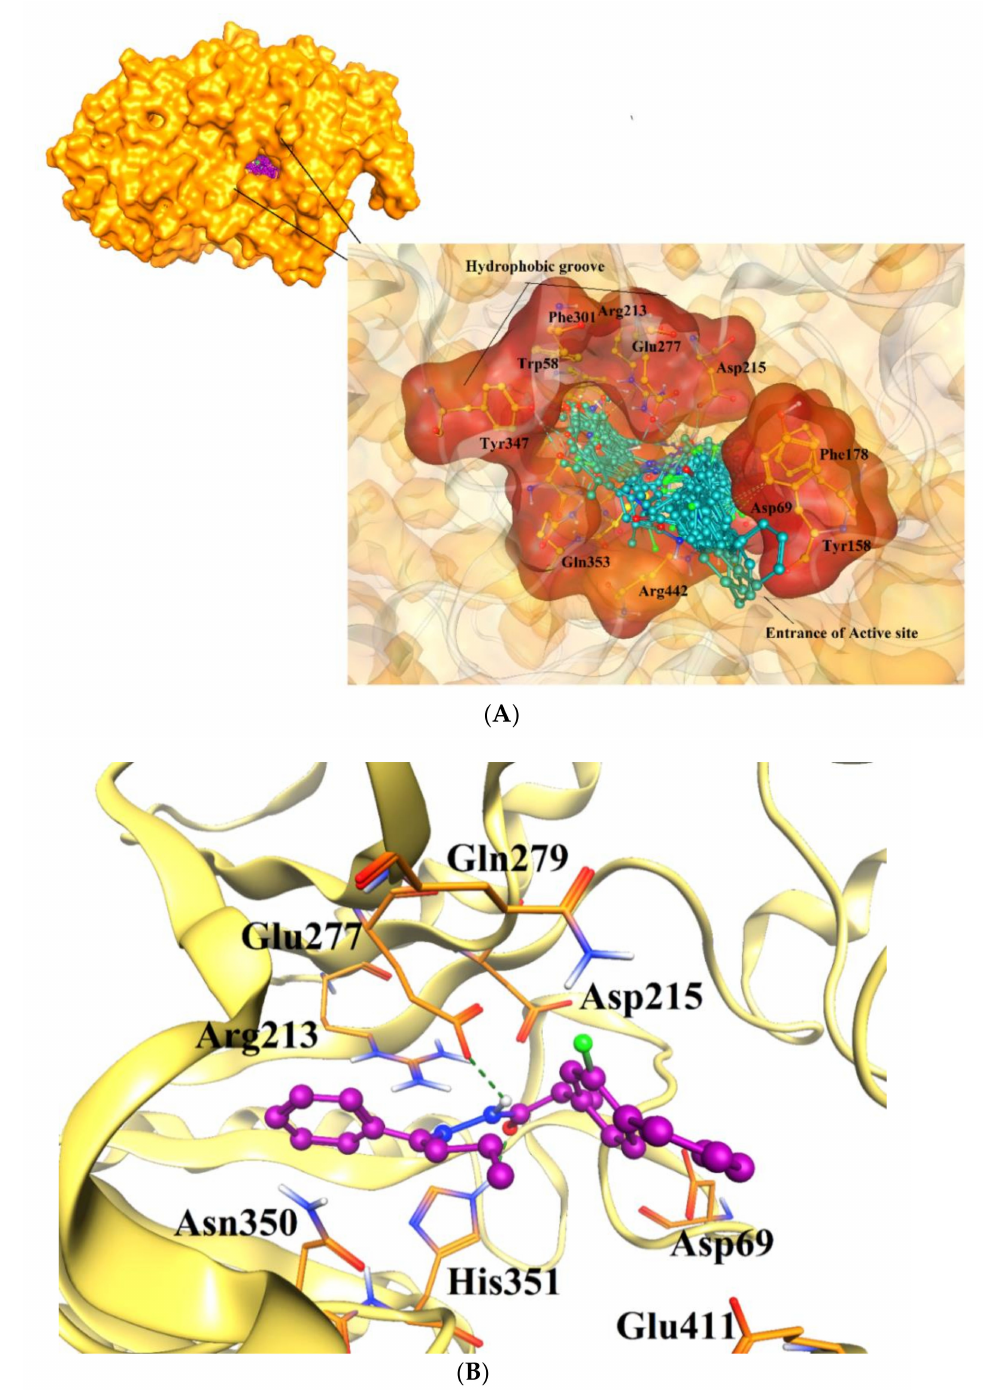
Figure 3. ( A ) The docked orientations of all the active compounds are shown in the active site of α -glucosidase enzyme. The entrance of the active site and the hydrophobic pocket is displayed in the surface model, the compounds are presented in cyan ball and stick model. ( B ) The binding mode of the most active compound ( 5k , shown in magenta ball and stick model) is displayed in the active site of α -glucosidase. The active site residues are presented in orange stick model, and the protein is shown in gold ribbon. The H-bonds are displayed in green dotted